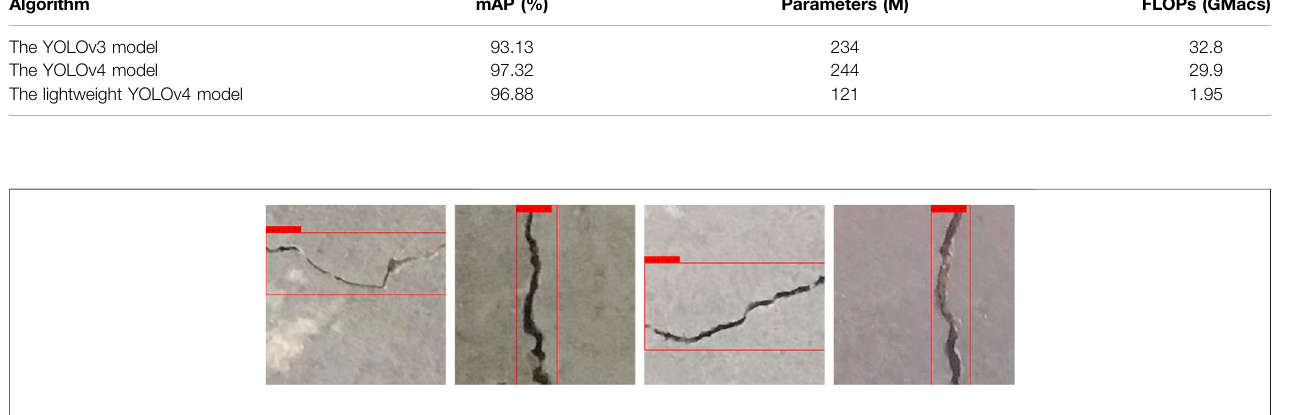
FIGURE 11 | The detection results of the concrete surface